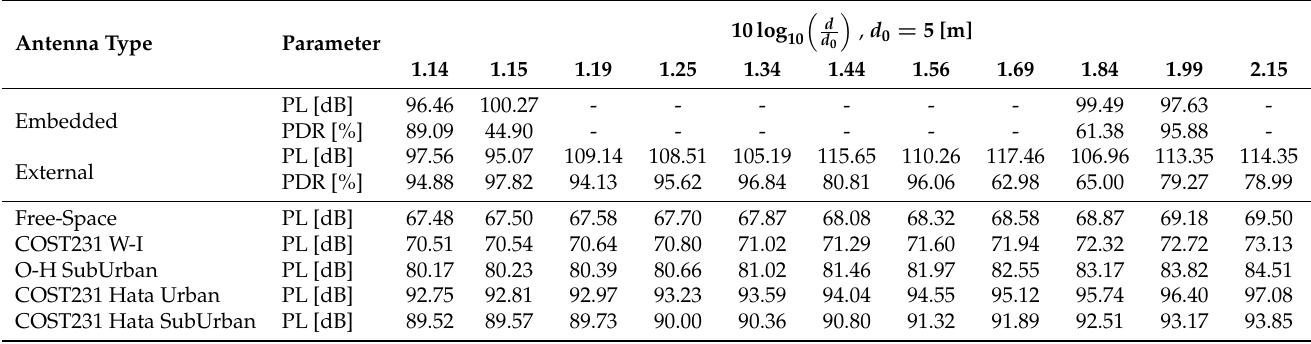
Table 8. Measured average path loss and Packet Delivery Ratio for Non-Line-of-Sight scenario (two turns).